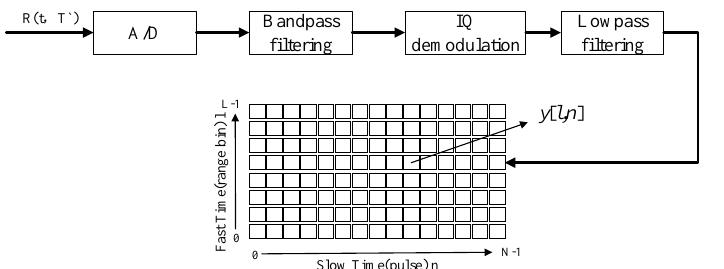
Figure 4. The flow of preprocessing.